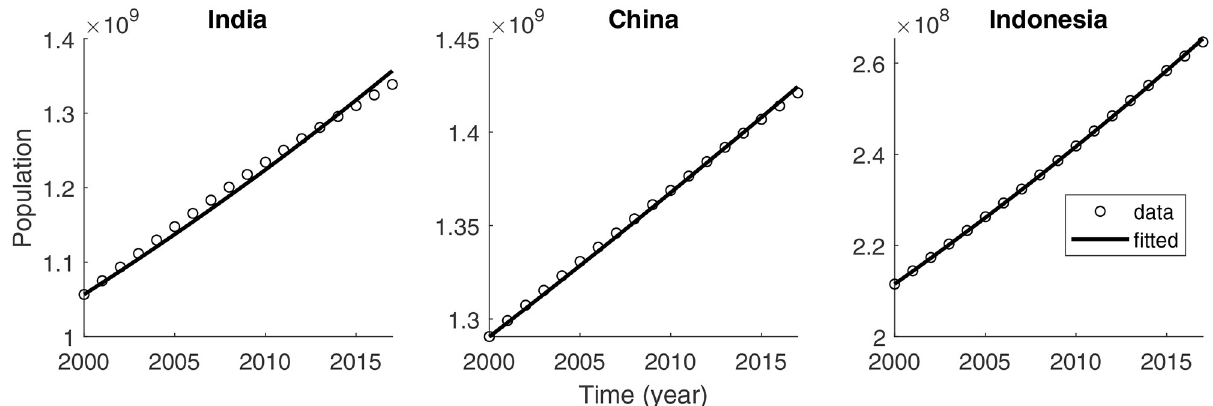
Fig 2. Total population data and the best fit of N ( t ) for India (left), China (middle), and Indonesia (right).